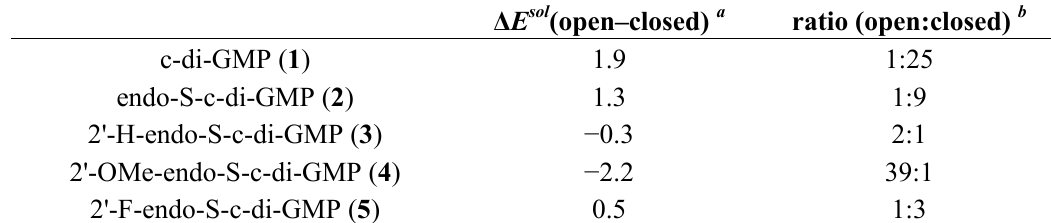
Table 1. Computed energy difference between “open” and “closed” forms of c-di-GMP ( 1 ) and analogues ( 2 – 5